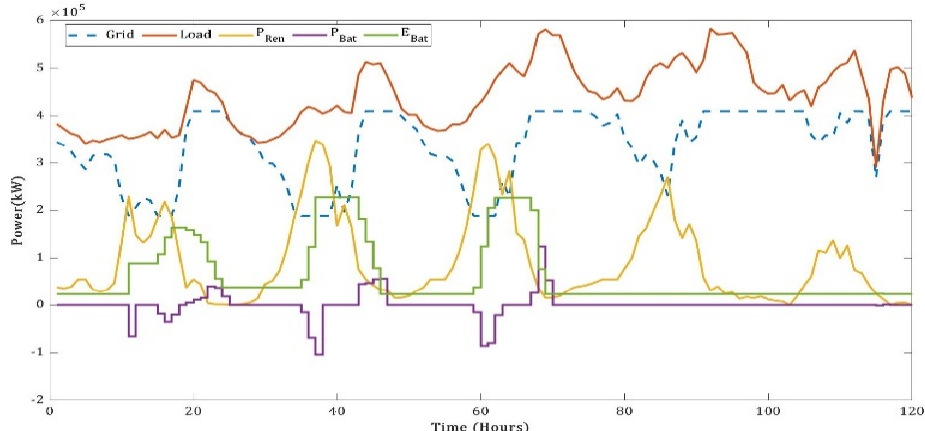
Figure 20. Power distribution with ALA-QPSO for the minimum LCOE for 21–26 June with 20% damage to the BESS and 20% demand appreciation assumed.